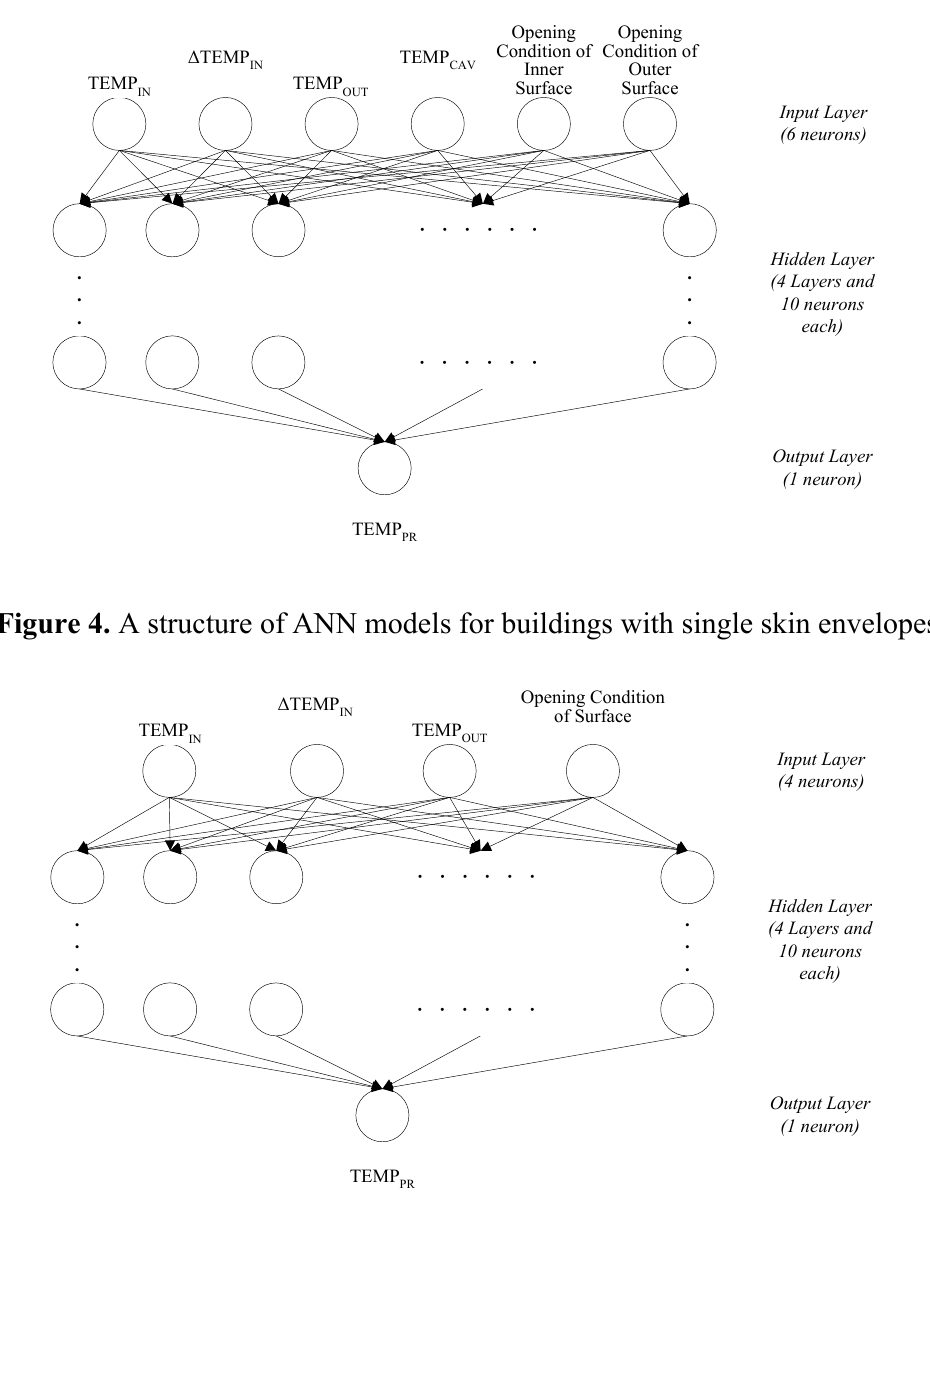
Figure 3. A structure of ANN models for buildings with double skin envelopes.